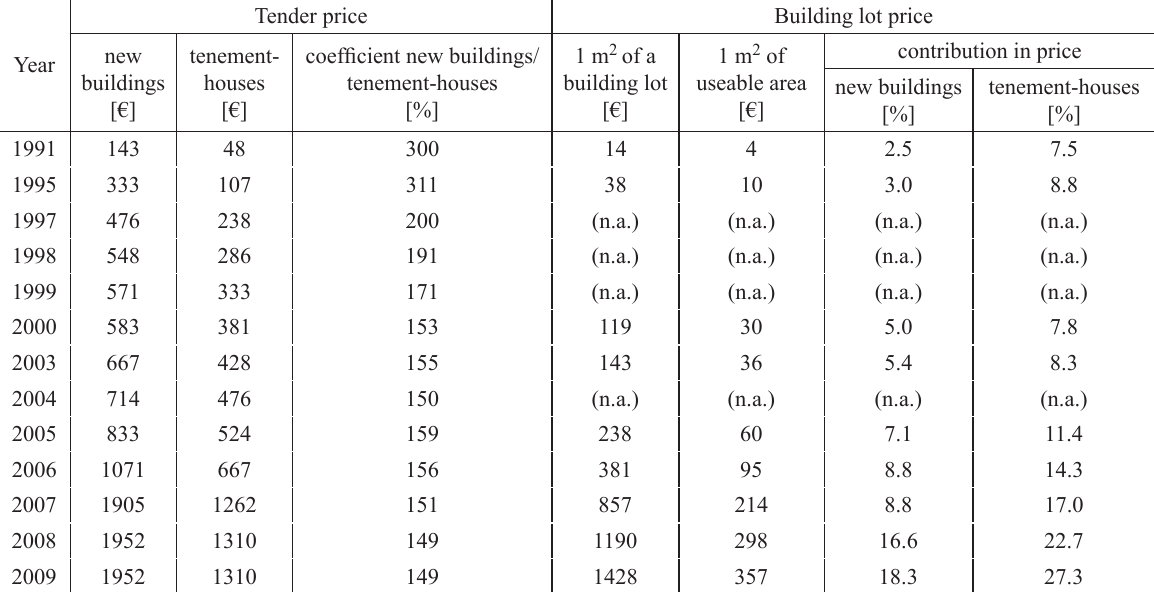
Table 3. The attractiveness tendency of the down-town tenement-houses in Wrocław (prices in €/1 m 2 of useable area)